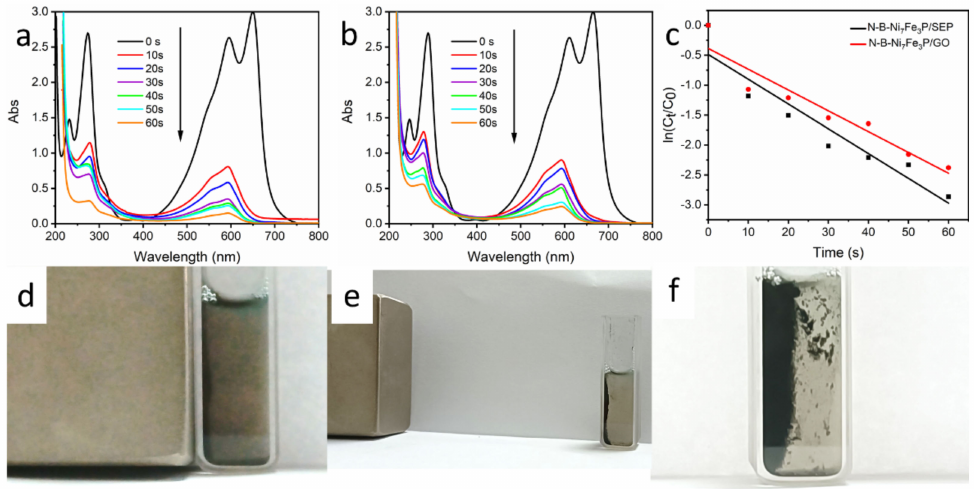
Figure 9. UV-Vis spectra of N-B-Ni 7 Fe 3 P/SEP ( a ) and N-B-Ni 7 Fe 3 P/GO ( b ) catalysed the reduction of MB by NaBH 4 ; ( c ) Plots of ln(C t /C 0 ) versus time; ( d – f ) Catalyst recovery process through magnets.